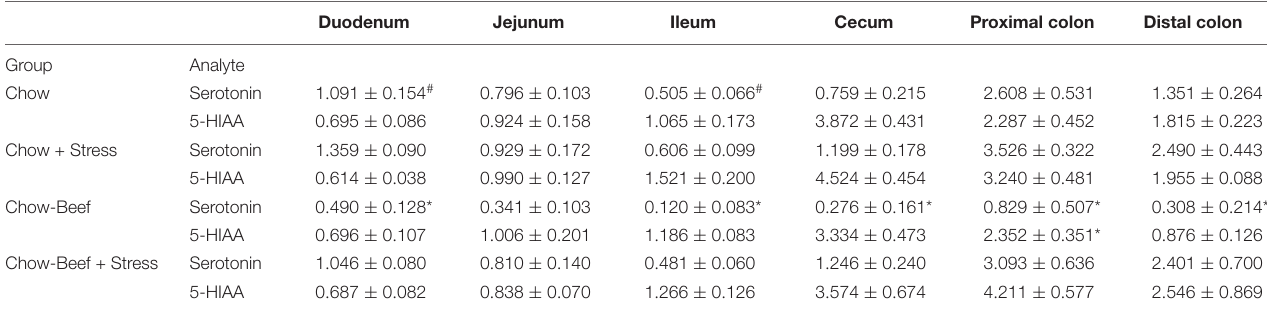
TABLE 2 | Serotonin and 5-HIAA concentrations in the female intestinal tract exhibit diet-dependent responsive to chronic stress.